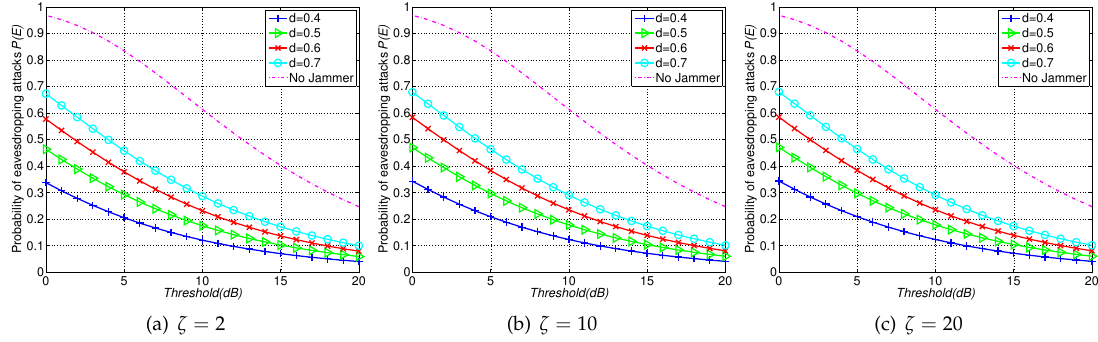
Figure 5. Probability of eavesdropping attacks P ( E ) with FJ-PC scheme versus Non-Jam scheme when ζ = 2,10,20 with SINR threshold T ranging from 0 dB to 20